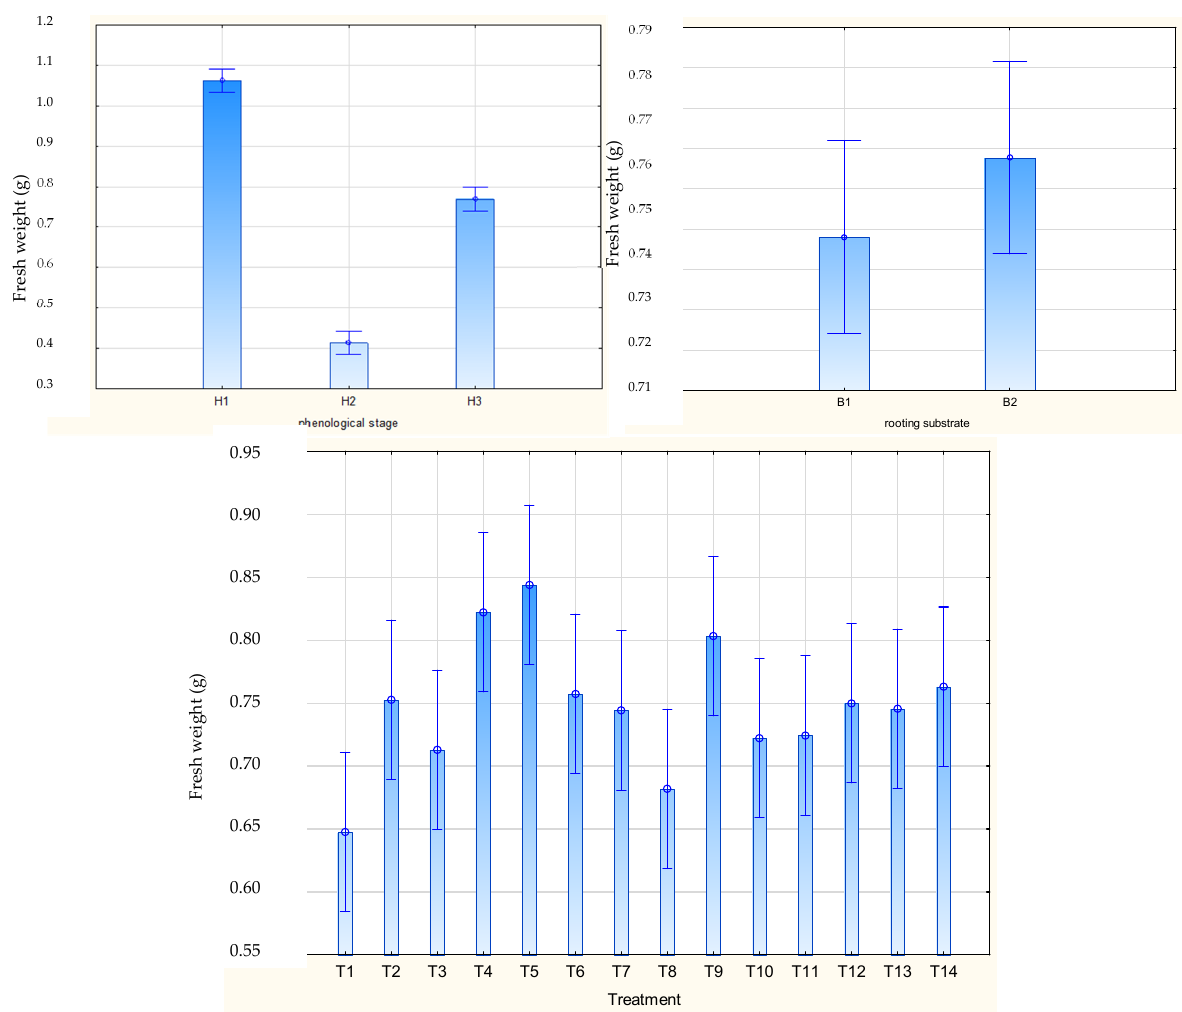
Figure 4. Fresh weight of Rosa ‘Hurdal’ cuttings prepared from three phenological stages (H1–H3) of shoots and rooted in two rooting substrates after treatment by rooting enhancers. B1—peat–perlite; B2—peat–sand; H1—flower buds closed (BBCH 54,504; flower buds still closed); H2—flowers opened (69,605; full flowering, at least 50% of flowers open); H3—immediately after petal shedding (69,629; end of flowering of second order stem: all petals fallen); and treated: T1—the control cuttings; T2—0.4% IBA (Ukorzeniacz A aqua ); T3—0.2% NAA (Ukorzeniacz B aqua ); T4, T5, T6, T7, T8, T9—Algae Extract: watering with 0.4% or 0.6% Bio Rhizotonic (10 mL) 1, 2, or 3 times (after planting and 10 and 20 days later); T10, T11, T12—Organic Preparation—watering with 0.1%, 0.2%, or 0.4% Root Juice™ (10 mL) after planting; T13, T14—Plant Extract—watering with 0.012% or 0.02% Bio Roots (10 mL) after planting. The degree of rooting on a 5-point scale: 1—only a callus, without formed roots; 2—at least one short root; 3—a few longer roots; 4—roots visibly developed, differentiated by the length; 5—strong roots starting to form a root ball, well developed. Vertical bars denote 95% confidence intervals for the mean of counts (one-way ANOVA). The highest mean percentage of Rosa ‘Hurdal’ cuttings with retained stock plant leaf was obtained after cutting from H3 shoots (H1; 95.8%) and was significantly lower after harvesting H2 cuttings (83.8%) and H3 shoots (77.1%) (Figure 5). The means for all phenology stages together were the highest by the use of one-time 0.6% Algae Extract, 0.4% Organic Preparation, and 0.012% Plant Extract. The lowest means were noticed for cuttings treated with IBA preparation and for the control cuttings (Figure 5). The rooting substrate did not affect all phenology stages of shoots in terms of the mean percentage of cuttings with a retained stock plant leaf (Figure